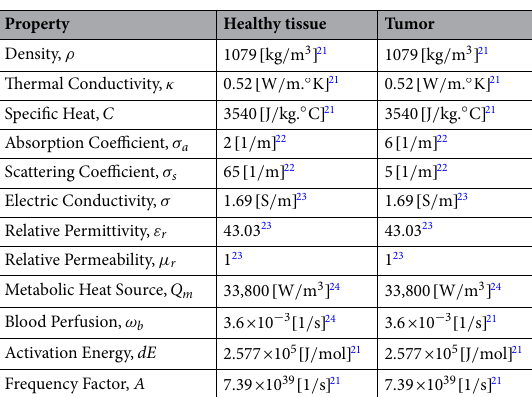
Property Healthy tissue Tumor Density, ρ